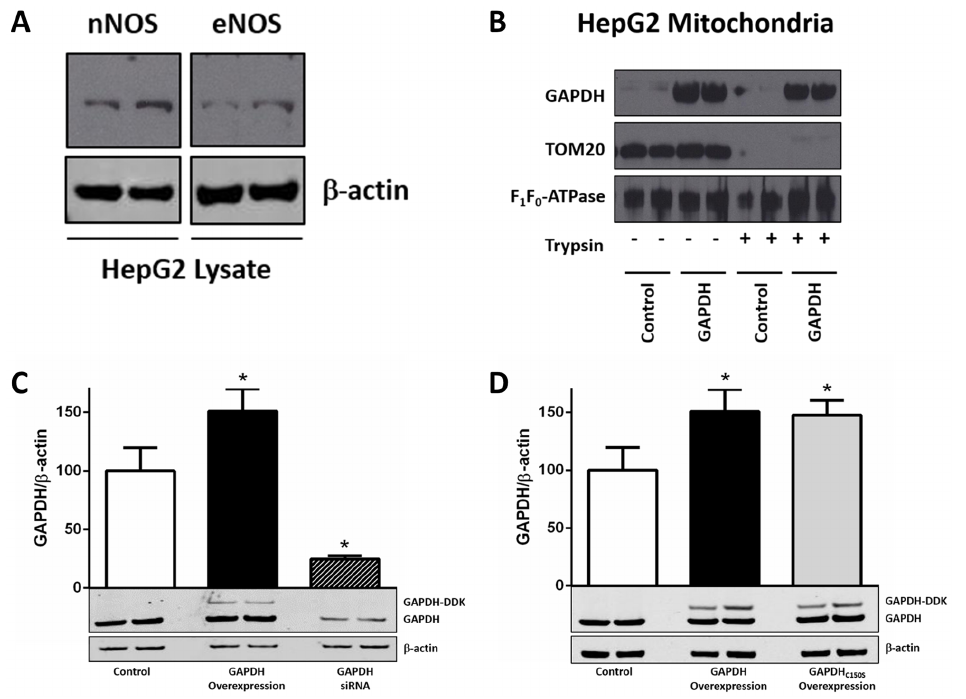
Figure 6. HepG2 cell line as a model system for examining GAPDH as a trans-S-nitrosylase. ( A ) Expression of neuronal and endothelial isoforms of NO synthase in HepG2 cells. Representative western blots are shown for neuronal (top right) and endothelial (top left) NO synthase and b - actin (lower). ( B ) Mitochondrial GAPDH protein levels were assessed after the addition of purified GAPDH to isolated HepG2 mitochondria. Representative western blots for GAPDH (upper), TOM20 (center), and the a subunit of F 1 F 0 -ATPase (lower) in HepG2 mitochondria. Control: non- treated mitochondrial control; GAPDH: purified GAPDH treated mitochondria; (n=3). ( C ) and ( D ) Hep2G cells were transfected with either a control GFP plasmid or siRNA scramble, a plasmid encoding DDK-tagged GAPDH for overexpression, a GAPDH siRNA for knock-down, or a plasmid encoding DDK-tagged GAPDH C150S for overexpression. Representative western blots are shown together with the densitometry of GAPDH normalized to b - actin for total GAPDH (upper; GAPDH, GAPDH-DDK, GAPDH C150S -DDK) and b -actin (lower; *p , 0.05 vs. control; n=6).